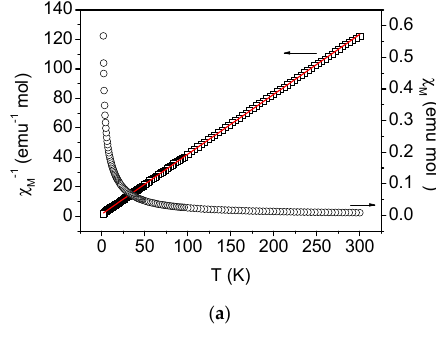
Figure 7. ( a ) Emission spectrum of 1 in a solid state at room temperature. ( b ) Emission spectra of 2 (black) and [BzQl]Br (red) in a solid state at room